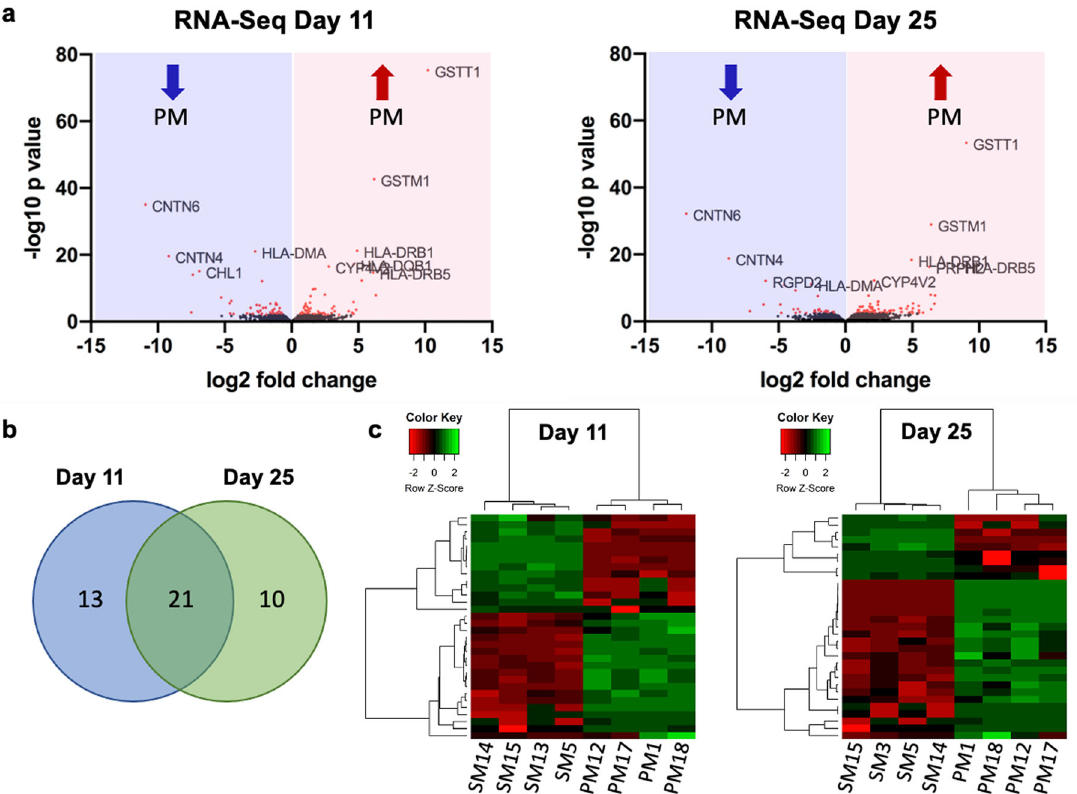
Fig. 3 RNA-seq at days 11 and 25 of dopaminergic differentiation. a Volcano plots illustrate the total number of genes sequenced (black) and genes showing signi fi cantly increased or decreased (red) expression levels in PM versus SM ( p < 0.01) on day 11 and day 25 of differentiation. The top 10 signi fi cant genes are identi fi ed on the plots. b Venn diagram indicating that 21 genes are differentially expressed in PM and SM on both days of differentiation, while 13 and 10 genes are differentially expressed on days 11 and 25, respectively (FDR < 0.05) c Heat map of the signi fi cantly differentially expressed genes (FDR <